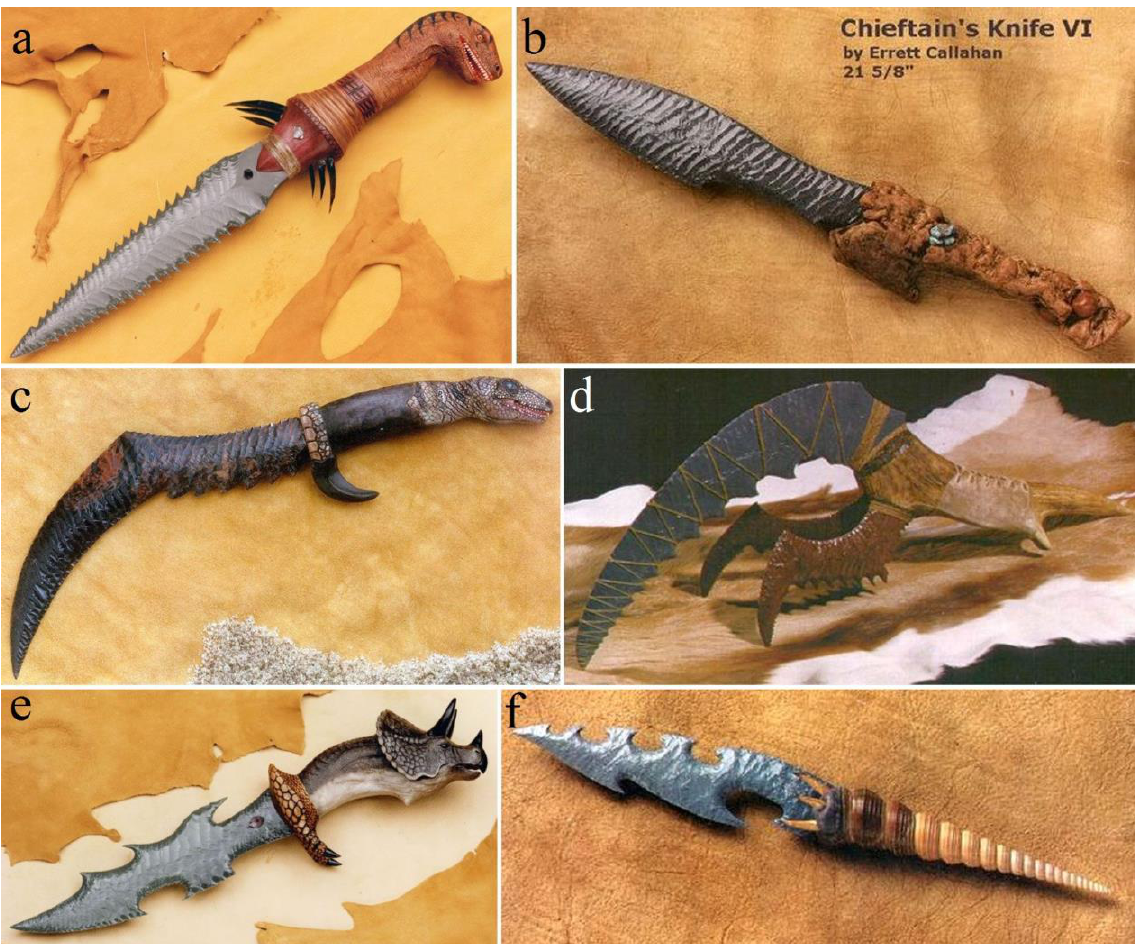
Figure 6. A sample of Callahan´s artistic knives creations. a) Allosaurus, b) Chieftain´s VI, c-d) Velociraptor I and III, e) Triceraptos, f) Neptune´s. (Photos after Callahan